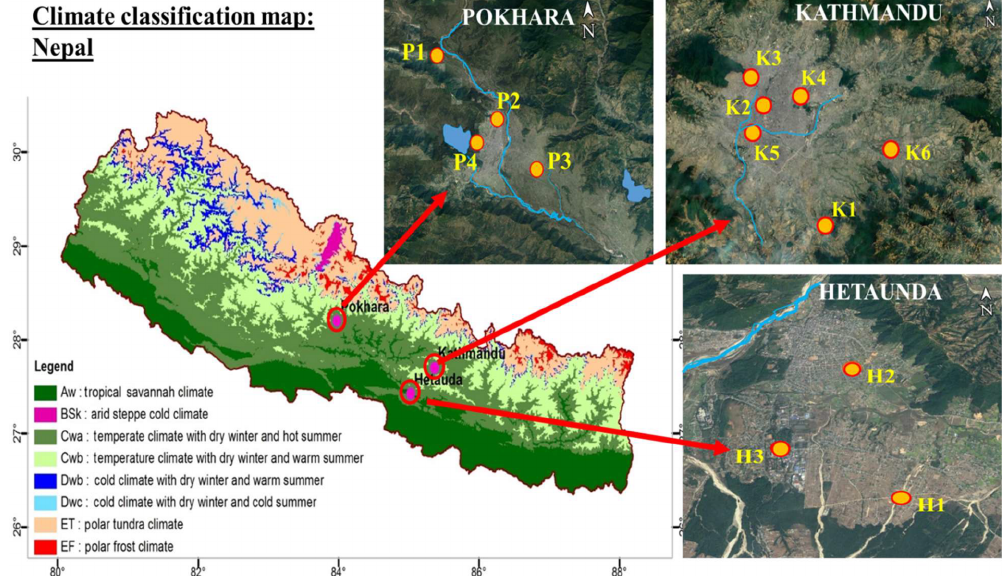
Figure 1. Map showing study area and sampling locations (modified from Karki et al., 2016).